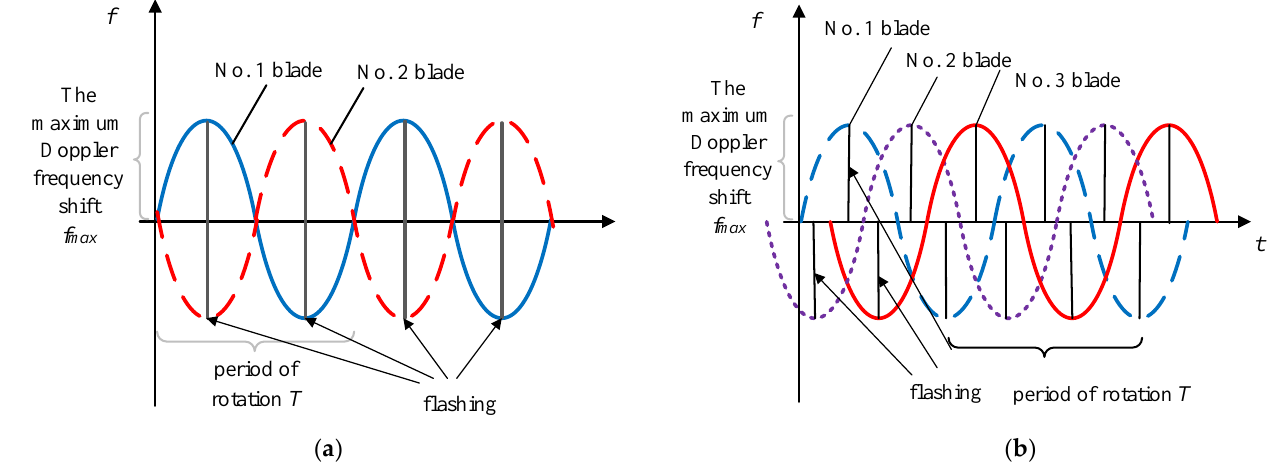
Figure 3. The micro-Doppler features of rotors with different numbers of blades: ( a ) The micro- Doppler features of a two-bladed rotor. ( b ) The micro-Doppler features of a three-bladed rotor.